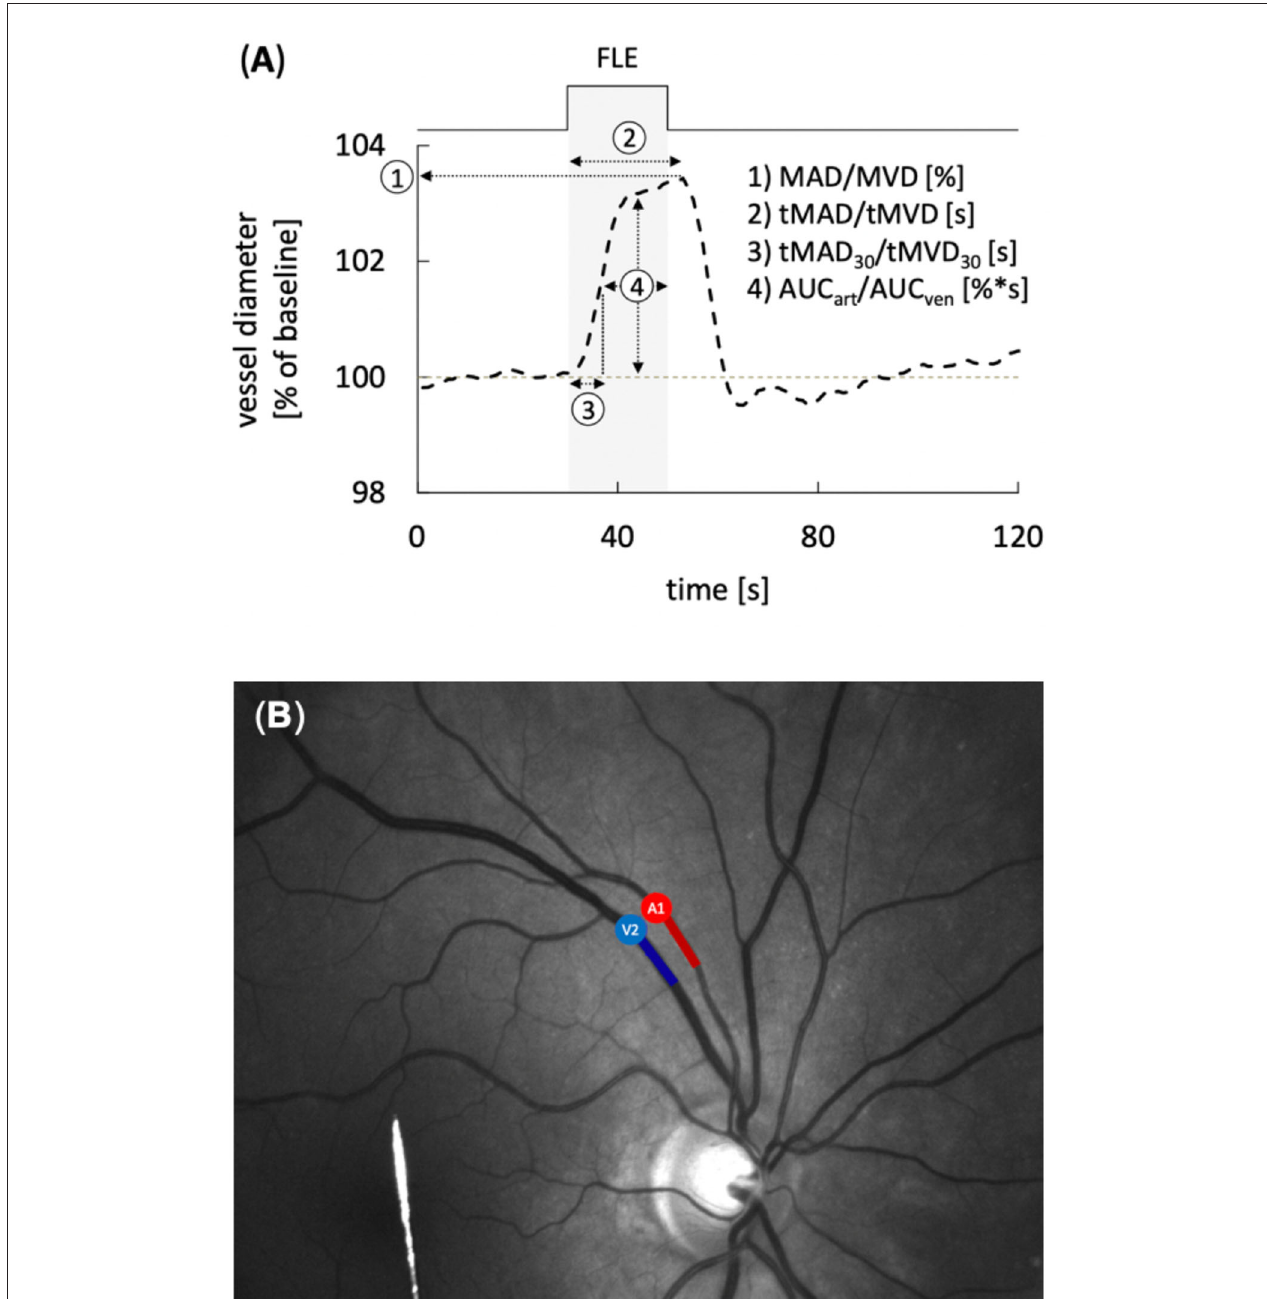
FIGURE 1 | Static and dynamic retinal vessel analysis (RVA). (A) Average retinal vessel response to flicker light excitation (FLE) in healthy subjects with the different parameters determined for dynamic RVA. The stimulation period is indicated above and by light gray shading. Parameters used for quantification of the response comprised maximum arterial or venous dilation (MAD/MVD), time to maximum arterial or venous dilation (tMAD/tMVD) relative to flicker initiation, time to 30% of the maximum arterial or venous dilation (tMAD 30 /tMVD 30 ) relative to flicker initiation, and arterial or venous area under the curve (AUC art /AUC ven ) during the FLE. (B) Example of a monochromatic fundus image used for RVA. Arterial (A) and venous (V) segments are indicated in red and blue,